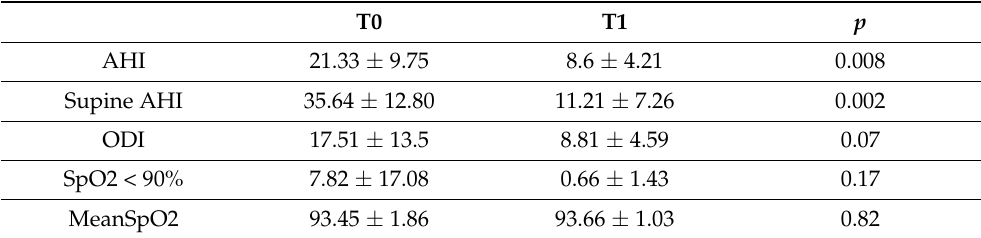
Table 2. Short-term effects of the appliance on respiratory variables in the six patients who continued with the therapy.